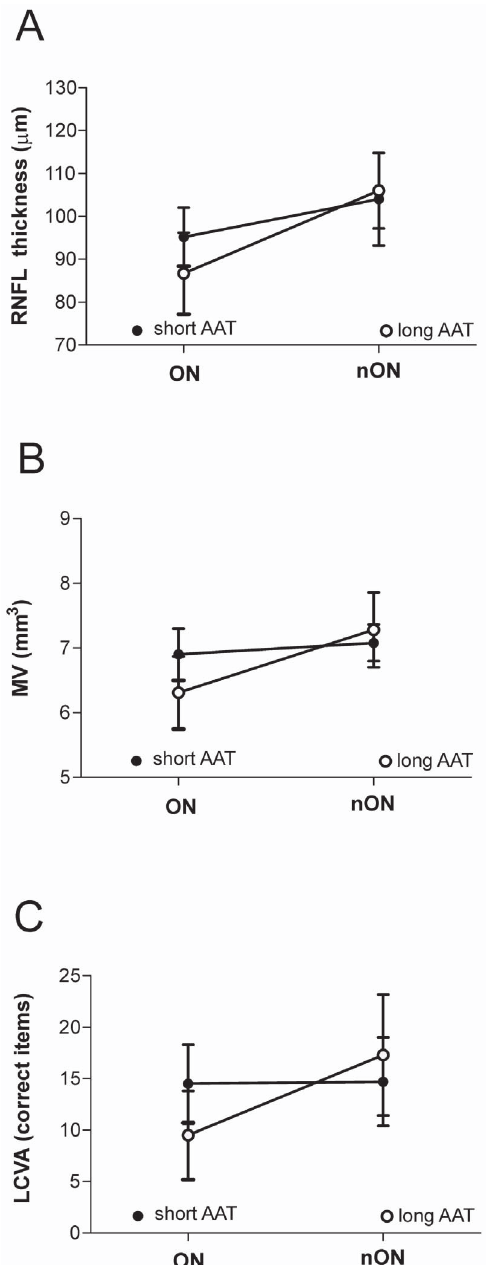
Figure 2. CNR1 (AAT)n influences the relationship between inflammation and neuronal atrophy in MS. A–C. Plot of interaction analysis between CNR1 genotype and previous optic neuritis (ON), analyzing RNFL thickness, MV and LCVA. A significant interaction between genotype and ON condition was found analyzing both RNFL thickness (A) and MV (B), confirming less severe neurodegenerative damage after inflammatory events in subjects with short AAT repeats. A significant interaction between the two conditions (genotype X ON) were also revealed by LCVA analysis (C), supporting the idea that the short AAT repeat genotype is associated with less severe visual impairment secondary to neuroinflammation in MS